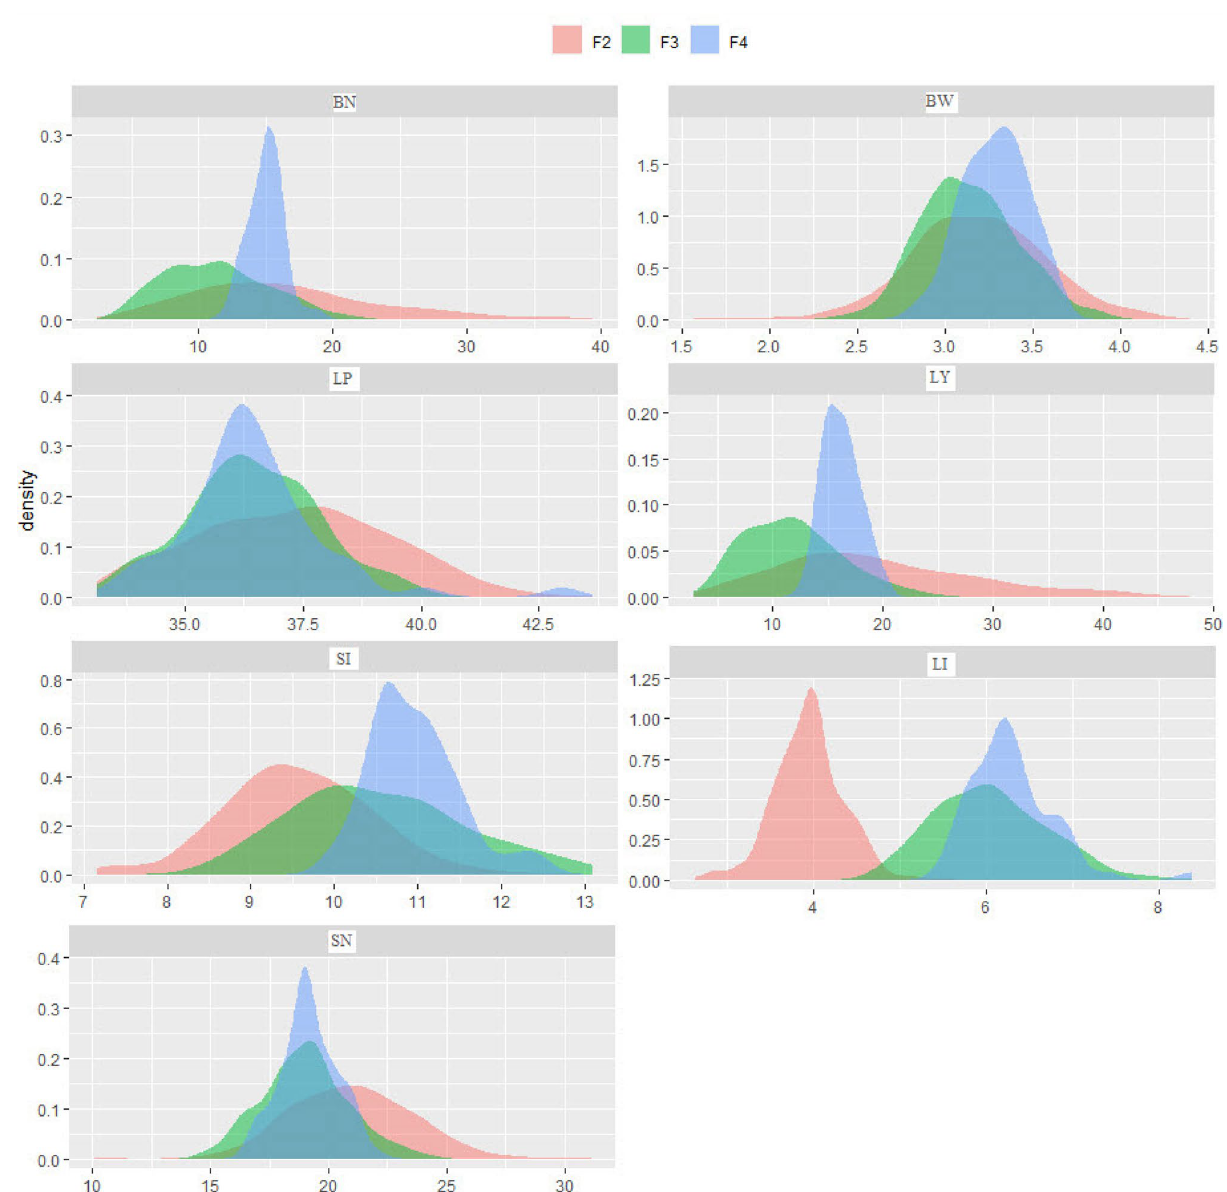
Figure 1. Density plot of boll number/plant (BN), boll weight (BW), lint % (LP), lint yield/plant (LY), seed index (SI), lint index (LI), and seed number/boll